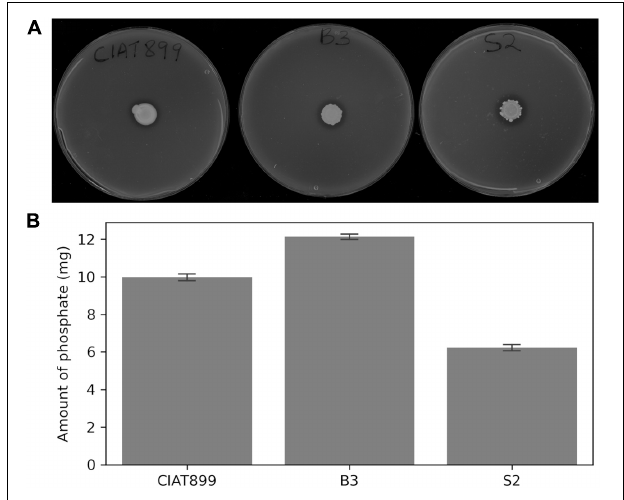
FIGURE 2 | Phosphate solubilization on Pikovskaya’s agar plates (A) and amount of solubilized phosphorus in NBRIP broth (B) of the rhizobia isolates. Bars represent standard errors based on three independent replications.